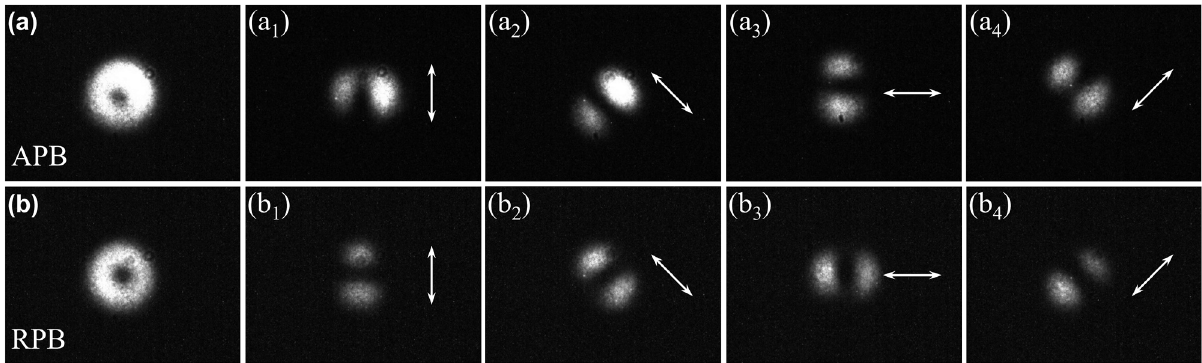
Figure 6: Output characteristics of the laser in spatial domain. (a) Spatial intensity distributions of the Q- switched APB and (b) that of the Q- switched RPB before and after passing a linear polarizer. The white arrows denote the transmission axis orientation of the polarizer.